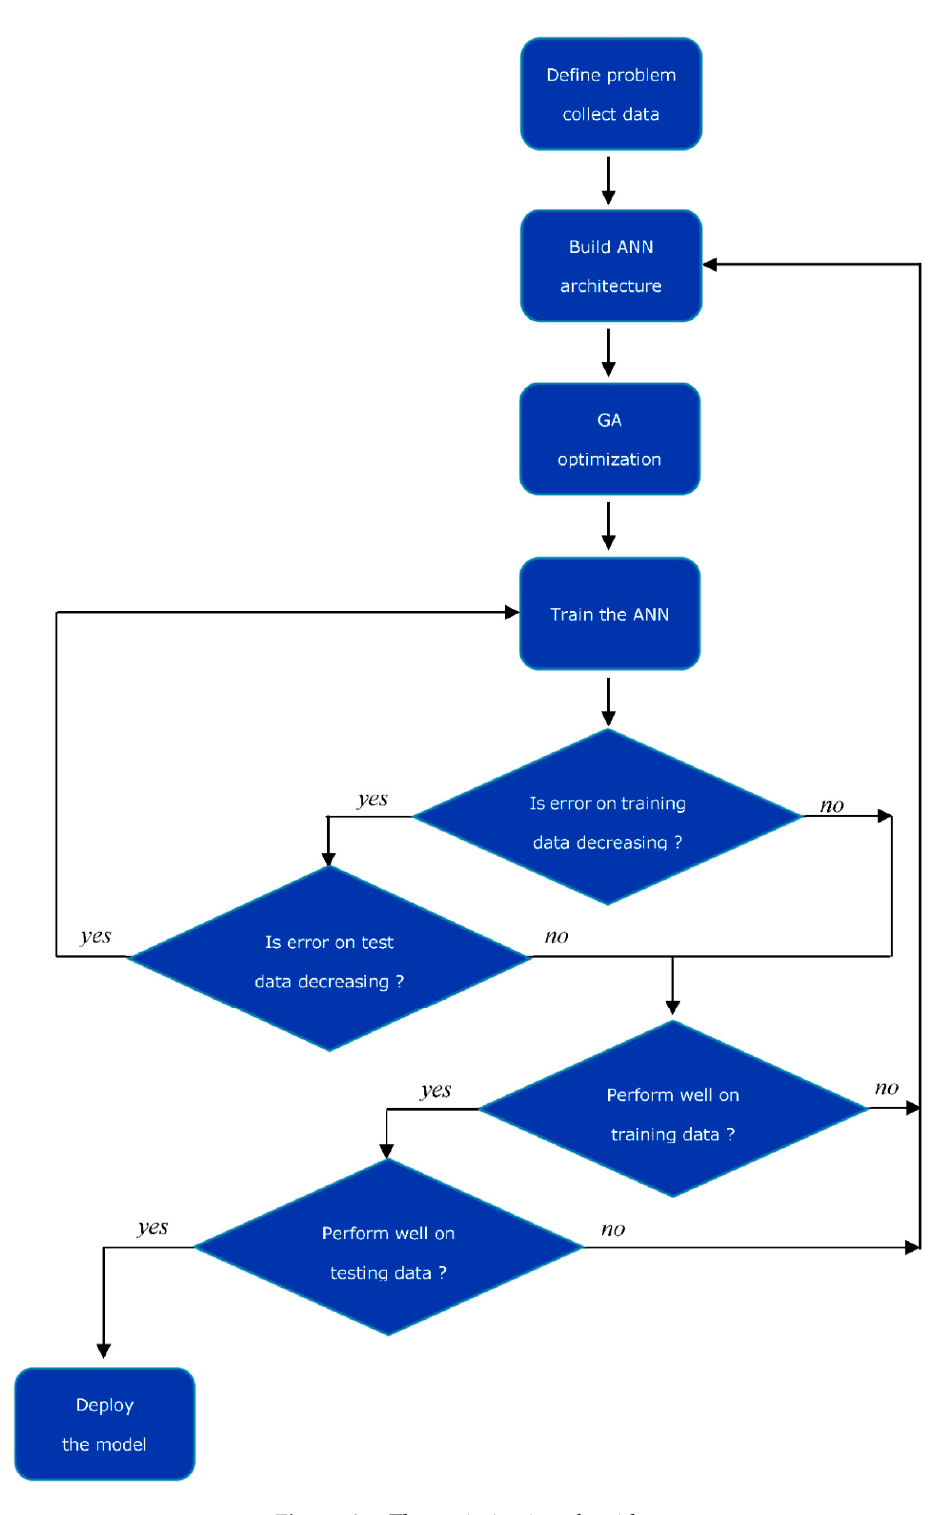
Figure A4. The optimization Figure A3. The optimization algorithm.